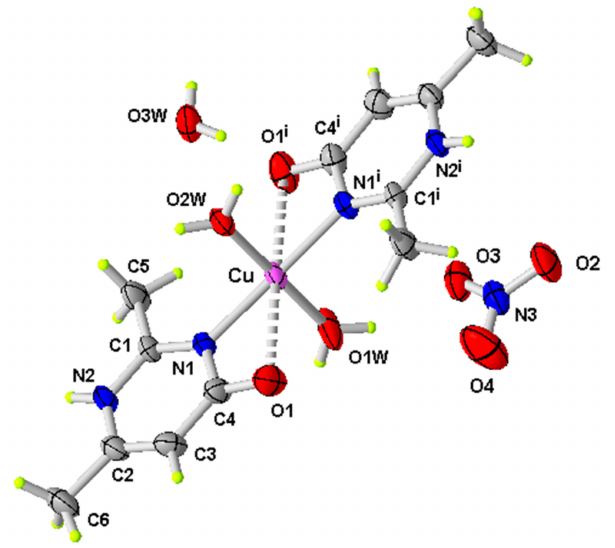
Figure 1. ORTEP of the structure of ( 1 ) with displacement ellipsoids drawn at the 50% probability level (i: − x, y, − z +